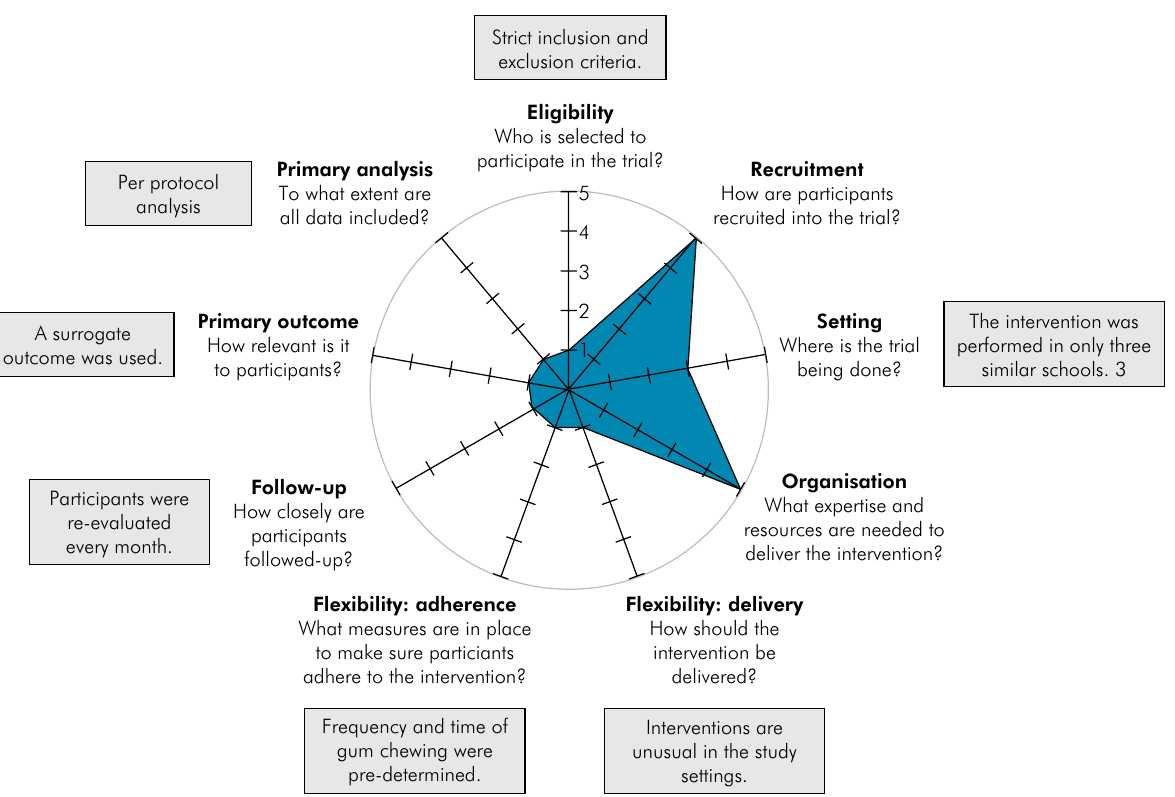
Figure. Pragmatism assessment of the identified trial using the pragmatic-explanatory continuum indicator summary (PRECIS2) diagram